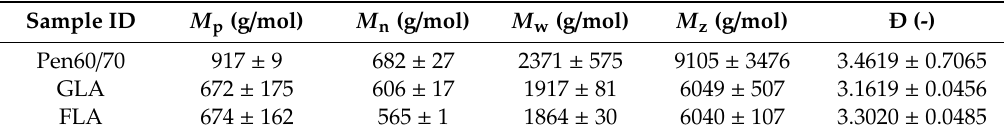
Table 6. Molecular weight distribution.